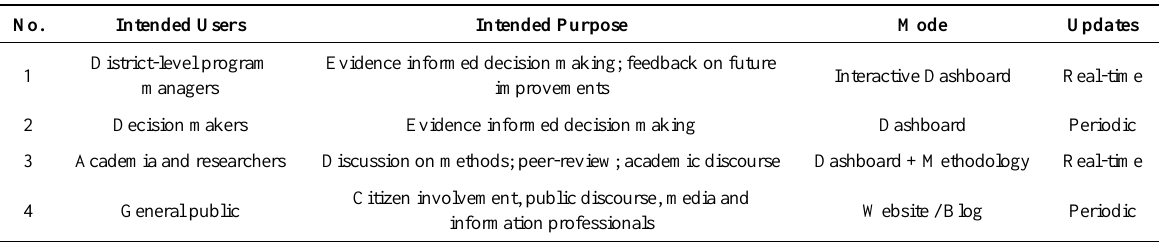
Table 2. Summary of the intended users of the data